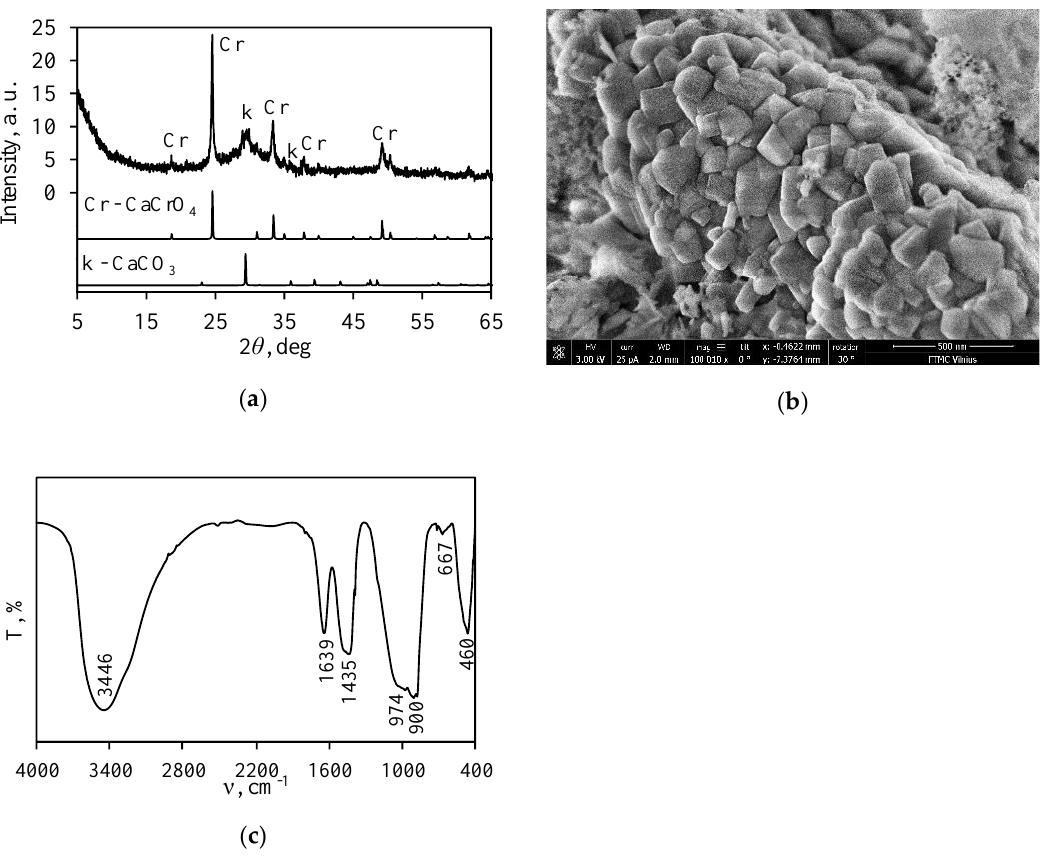
Figure 3. XRD pattern ( a ), SEM image ( b ), and FT-IR spectrum ( c ) of the calcined sample at 550 °C. Indexes: k—CaCO 3 ; Cr—CaCrO 4